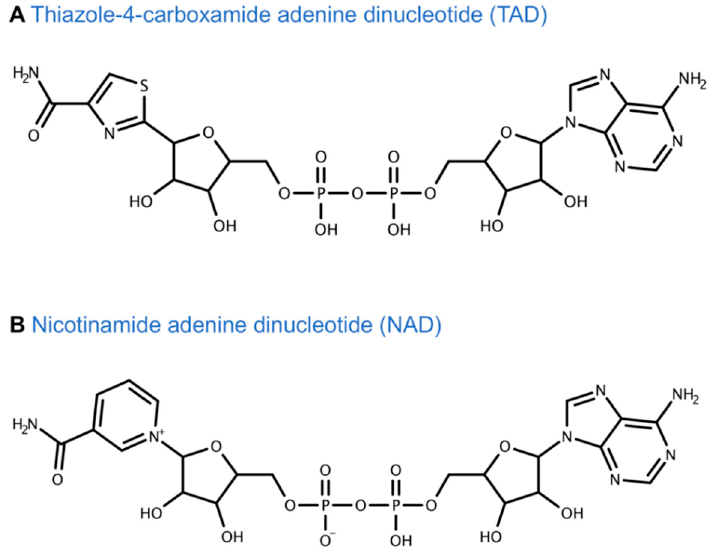
Figure 6. TAD and NAD chemical structures.